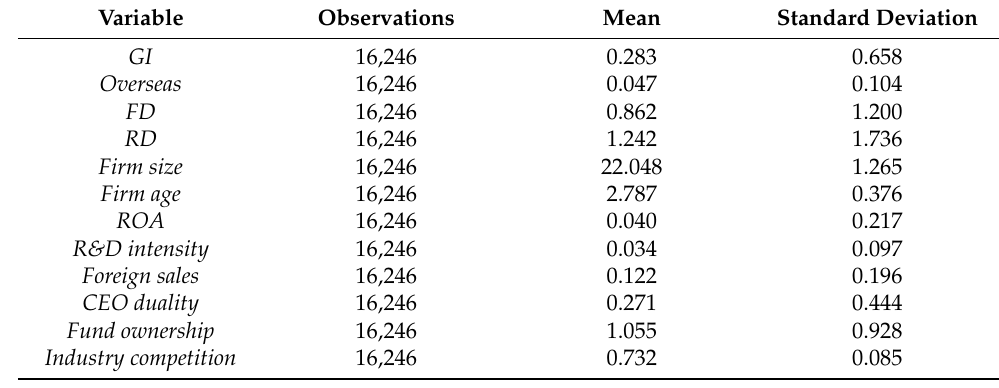
Table 2. Descriptive statistics.